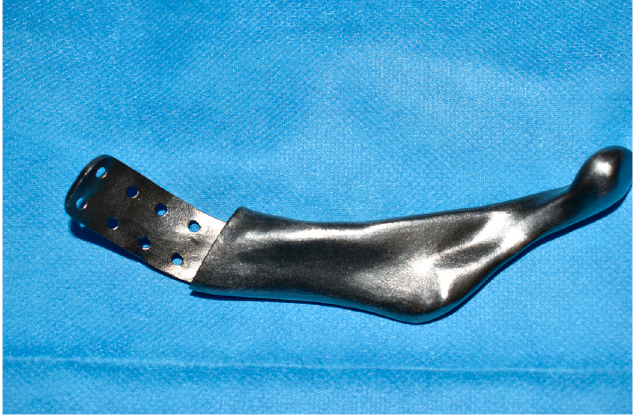
Figure 5. CAD-CAM custom-made hemi-mandibular prosthesis.